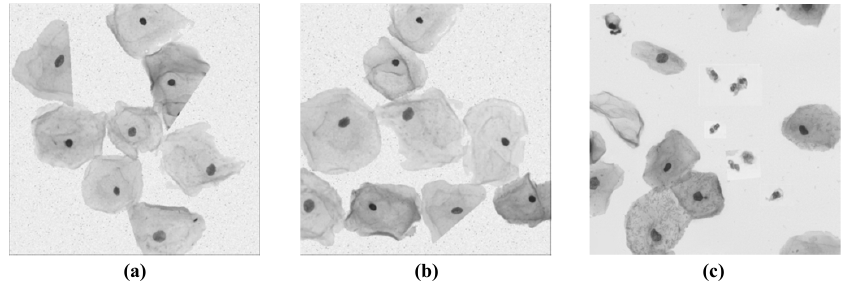
Figure 1. Examples of various challenges. ( a ) The complex structure of cervical cells, including differences in cell shape, color, number, distribution, etc. ( b ) Blurred cell boundaries caused by uneven lighting and staining conditions. ( c ) Blood stains, bacteria, and other impurities remained in the Pap